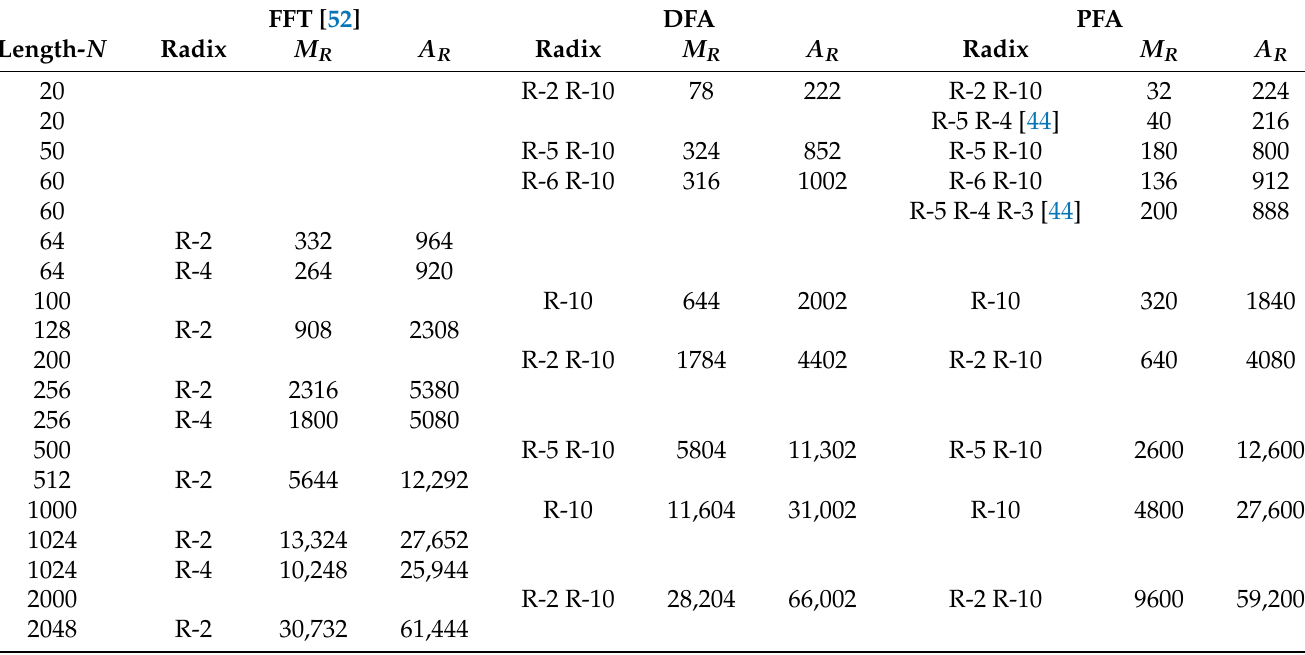
Table 2. The number of real multiplications M R and additions A R for DFT